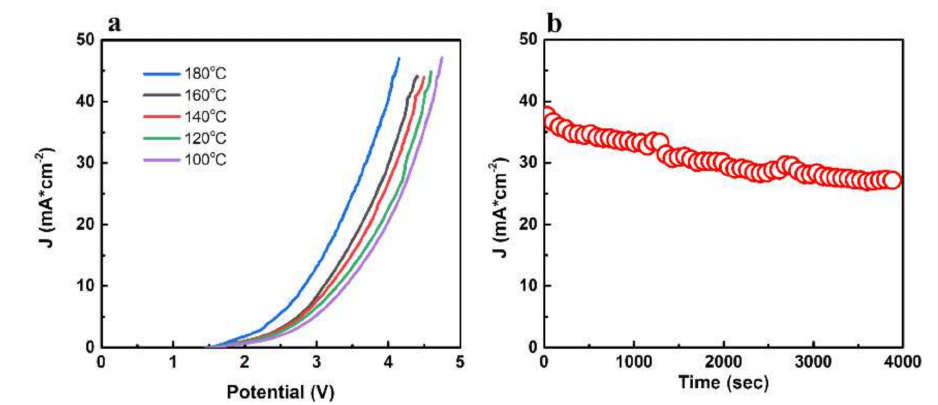
Figure 6. ( a ) Polarization curves of electrolysis cells using PVC-P4VP (1:2)/PA membranes at different temperatures and ( b ) stability of electrolysis cells using PVC-P4VP (1:2)/PA membranes at 180 ◦